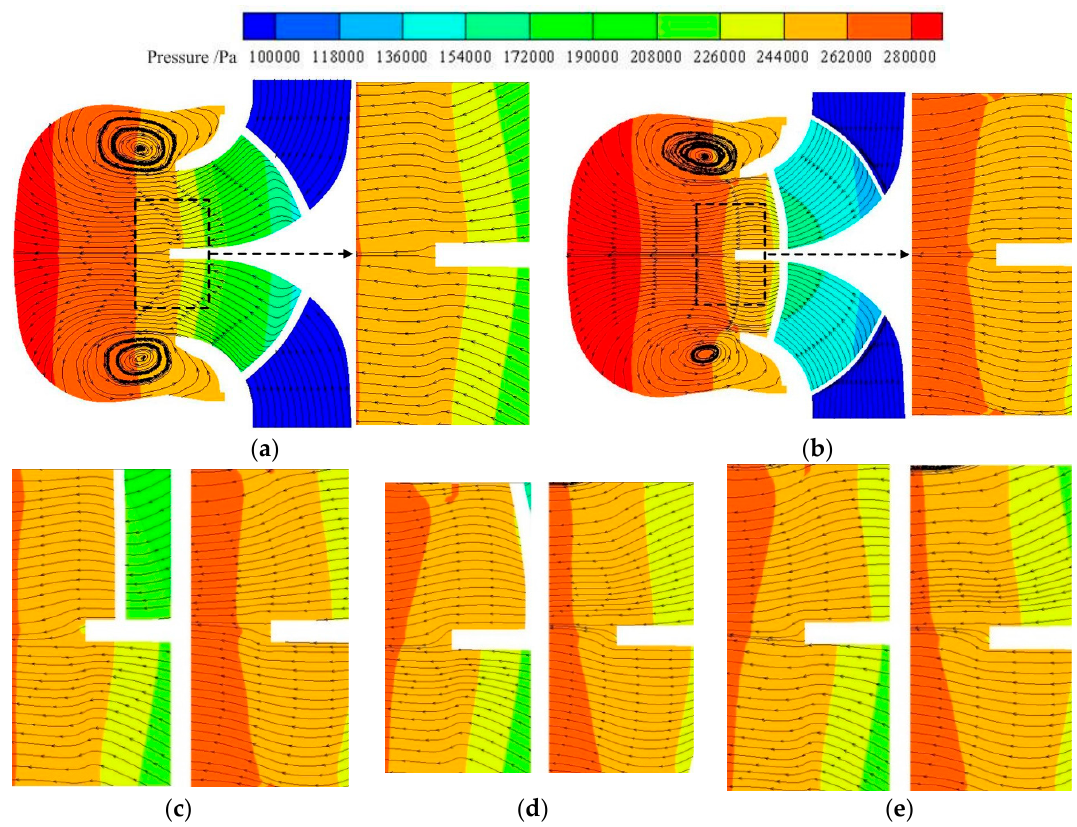
Figure 7. The streamlines and pressure distribution on section1 and section2. ( a ) Case0, section1; ( b ) Case0, section2; ( c ) Case10 ( d ) Case20; ( e ) Case30.